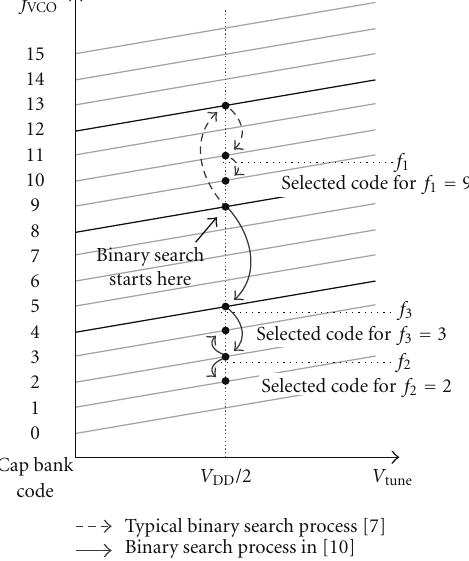
Figure 6: Final code selection of binary search process for various target frequencies in previous techniques. For f 1 , typical binary search process is used [7], and improved algorithm in [10] is applied for f 2 and f 3